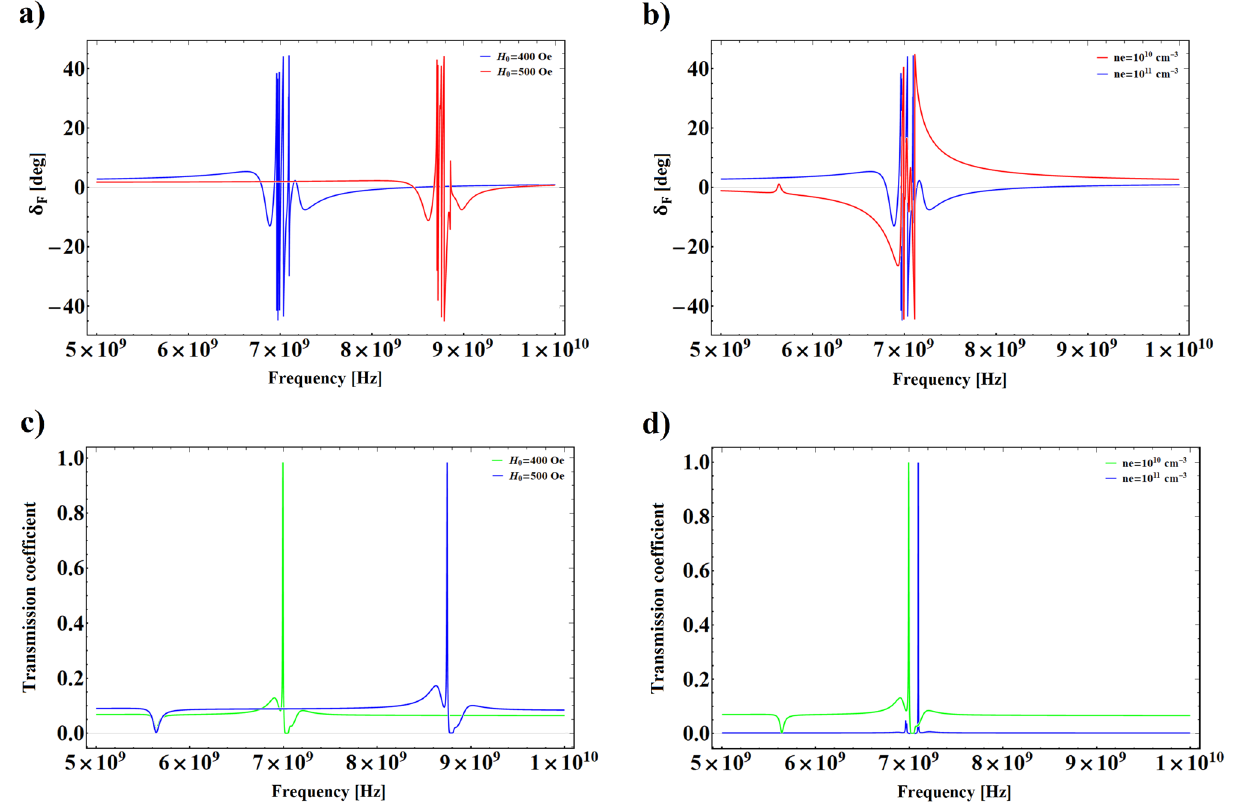
Figure 3. (a,b) FRA of transmitted VB beam versus incident wave frequency for different values of external electric field and plasma number density, respectively. (c,d) The total transmission coefficient as a function of incident wave frequency for different values of external electric field and plasma number density,